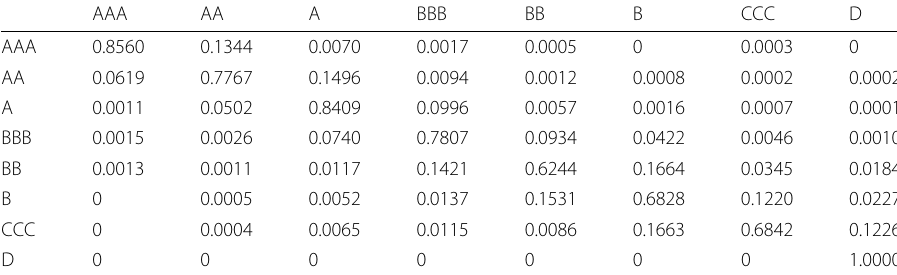
Table 1 2 step transition probability matrix for Industry